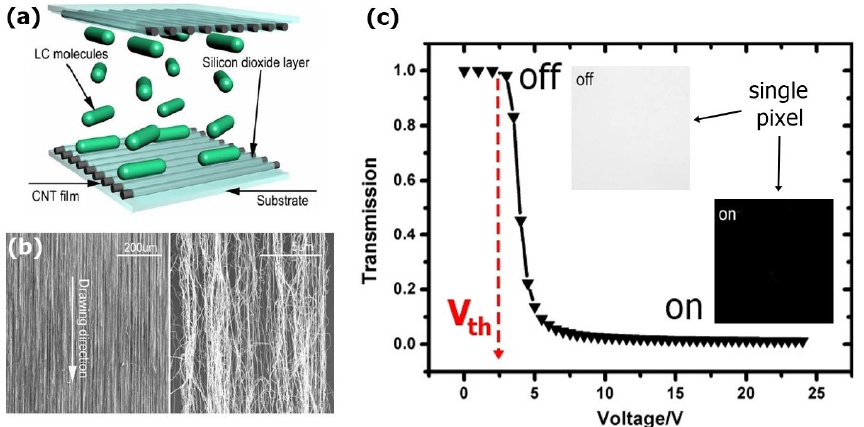
Figure 8. ( a ) Schematic illustration of a twisted nematic (TN) cell using a film of oriented carbon nanotubes as electrodes and at the same time as an alignment layer for the liquid crystal molecules. ( b ) SEM images at different magnification of such an aligned carbon nanotube film. ( c ) Electro-optic switching curve of a TN cell with carbon nanotube electrode/alignment films, switching from bright at zero applied voltage to dark at applied electric field above a threshold voltage. (Reproduced by permission from reference [111]).